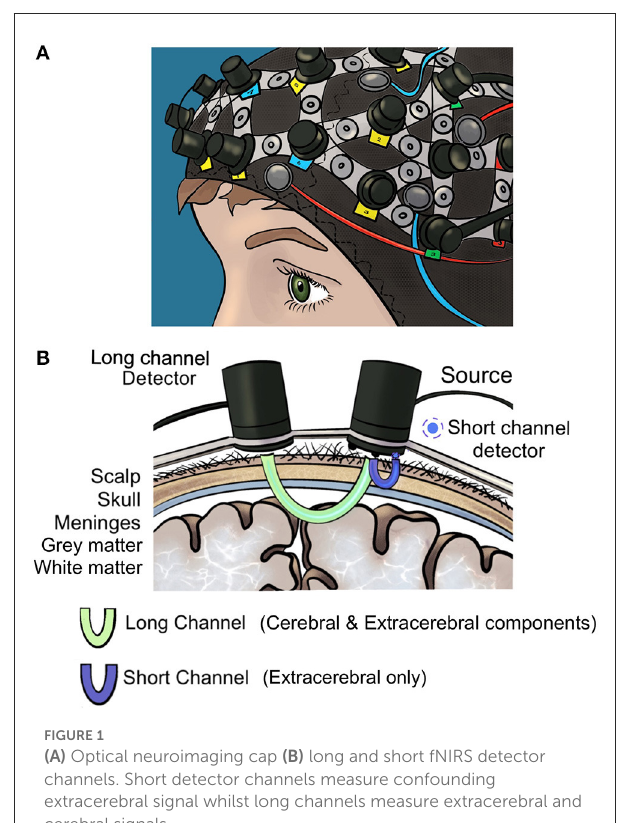
FIGURE1 (A) Optical neuroimaging cap (B) long and short fNIRS detector channels. Short detector channels measure confounding extracerebral signal whilst long channels measure extracerebral and cerebral